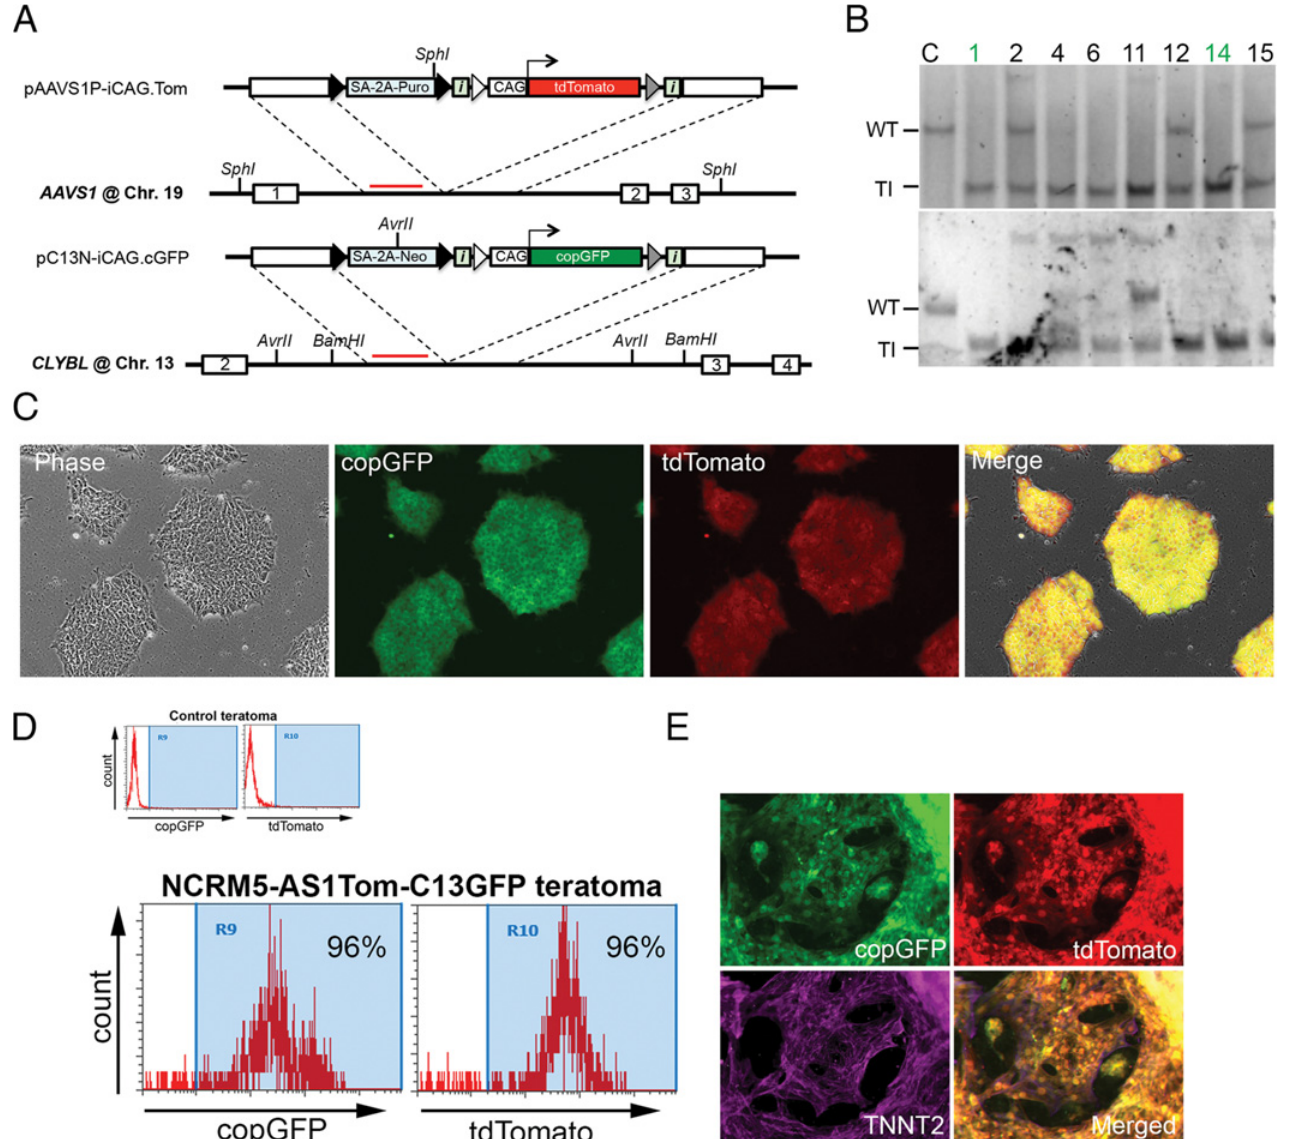
Figure 3. Double safe-harbor targeting in human iPSCs. (A) Schematic of dual safe-harbor gene addition of CAG-tdTomato in AAVS1 and CAG-copGFP in CLYBL . The elements shown are similar to those in Figs. 1 and 2. Red bars indicate AAVS1 or CLYBL probes, used with SphI, AvrII or BamHI digestion in Southern blot analysis. (B) Southern blot of dual safe-harbor targeted iPSC clones. Top and bottom panels are results from AAVS1 probe/SphI digestion and CLYBL probe/AvrII digestion, respectively. The sizes of WT and TI bands were the same as shown in Fig. 1 and 2. Green numbers indicate clones with all four alleles targeted. (C) Phase contrast, copGFP and tdTomato fluorescent images of dual safe-harbor targeted iPSC NCRM5-AS1Tom-C13GFP clone 1. Merged image is from both fluorescent channels plus phase-contrast image. (D) After an 8-week in vivo differentiation, teratoma cells were isolated and still showed robust dual transgene expression by flow cytometry. (E) High-efficiency directed differentiation into beating cardiomyocytes expressing TNNT2 and both fluorescent proteins (also shown by online supplementary videos).